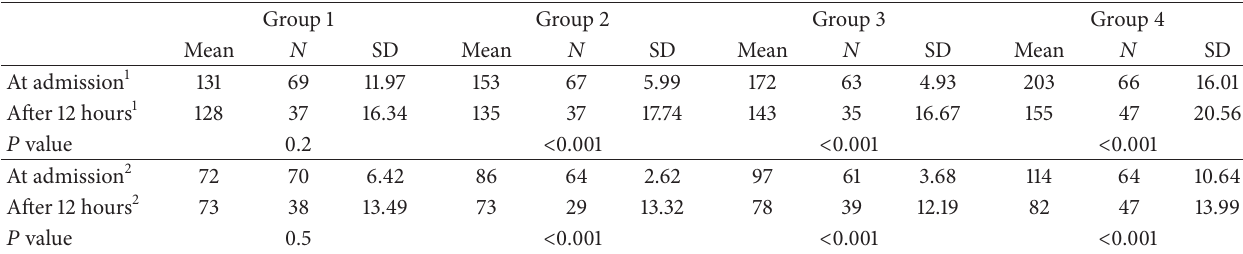
Table 2: Decrease in blood pressure from admission time to 12 hours after